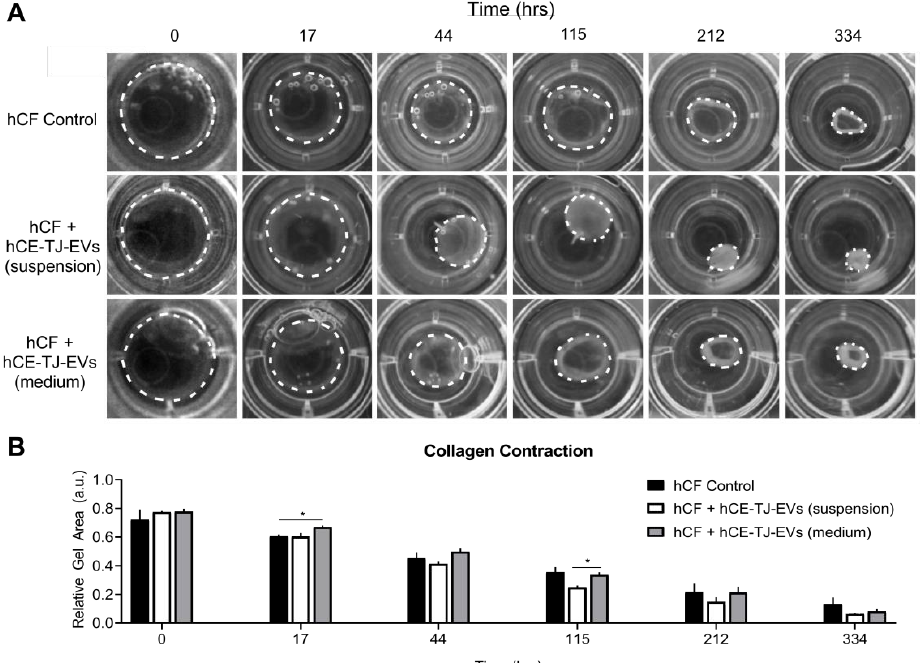
Figure 5. hCE-TJ-derived EVs increase corneal fibroblast contraction in floating collagen type I gels. ( A ) Representative brightfield images of floating hCF collagen gels over time. The dotted circle denotes the periphery of the collagen gel. hCFs suspended in collagen gels and maintained in complete fibroblast medium ± hCE-TJ-derived EVs for 0–334 h. Then, 25 µ g / mL of EV protein was encapsulated within the collagen gel with hCFs (suspension) or included within the medium (medium). ( B ) Quantification of collagen contraction over time. n = 4. Error bars represent SEM. * p ≤ 0.05 based on a two-way ANOVA.